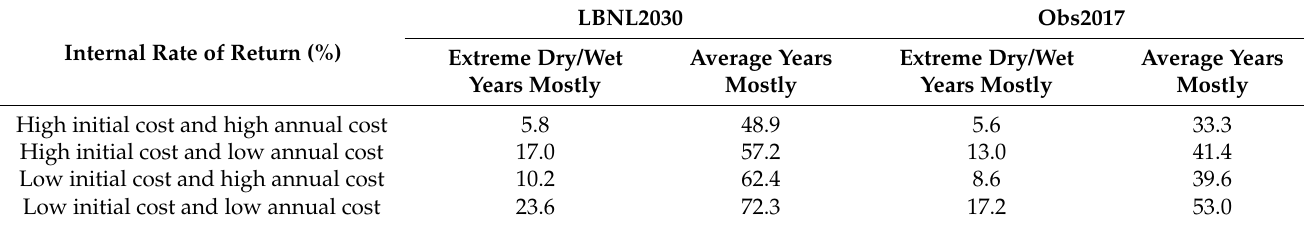
Table 4. Calculation of internal rate of return under the two prices